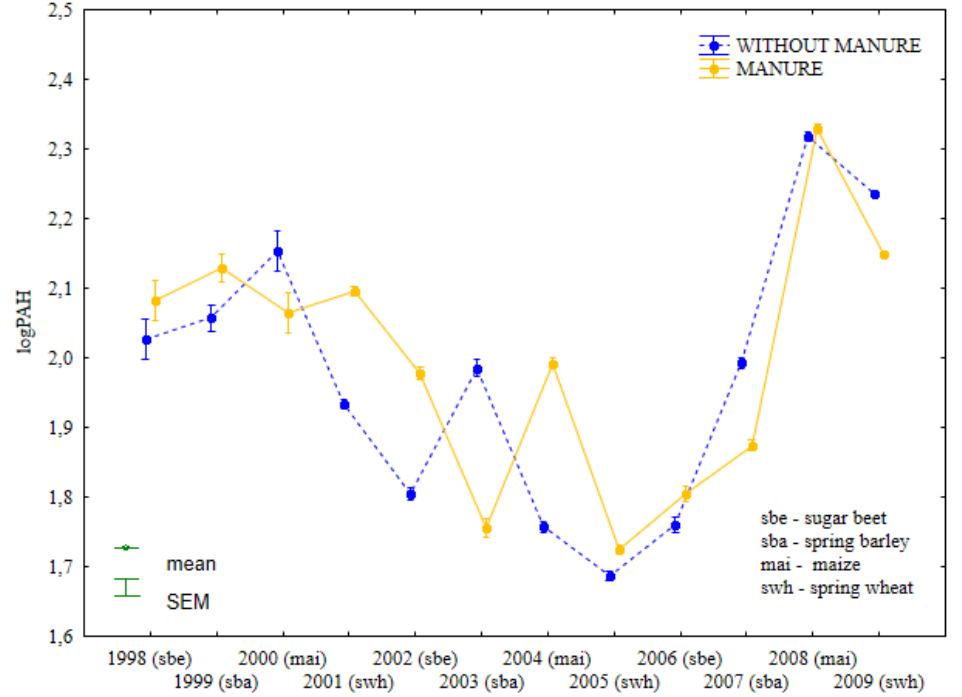
Figure 4. Total content of heavy PAHs in soil under different crops in treatments supplied with both manure and mineral fertilizers or mineral fertilizers only (log transformed data for 1998–2009).